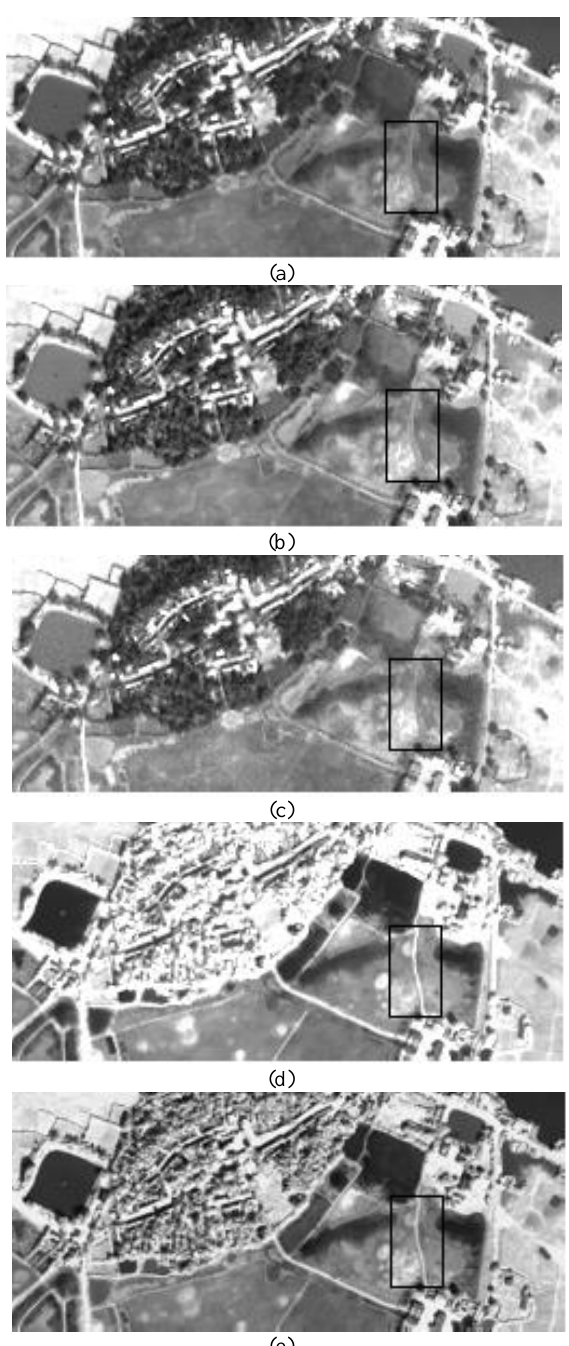
Figure 1. Illustration of object disappearances in satellite imagery (a) Red band. (b) Green band (c) Blue band (d) NIR band. (e) PAN band down-sampled to spatial resolution of